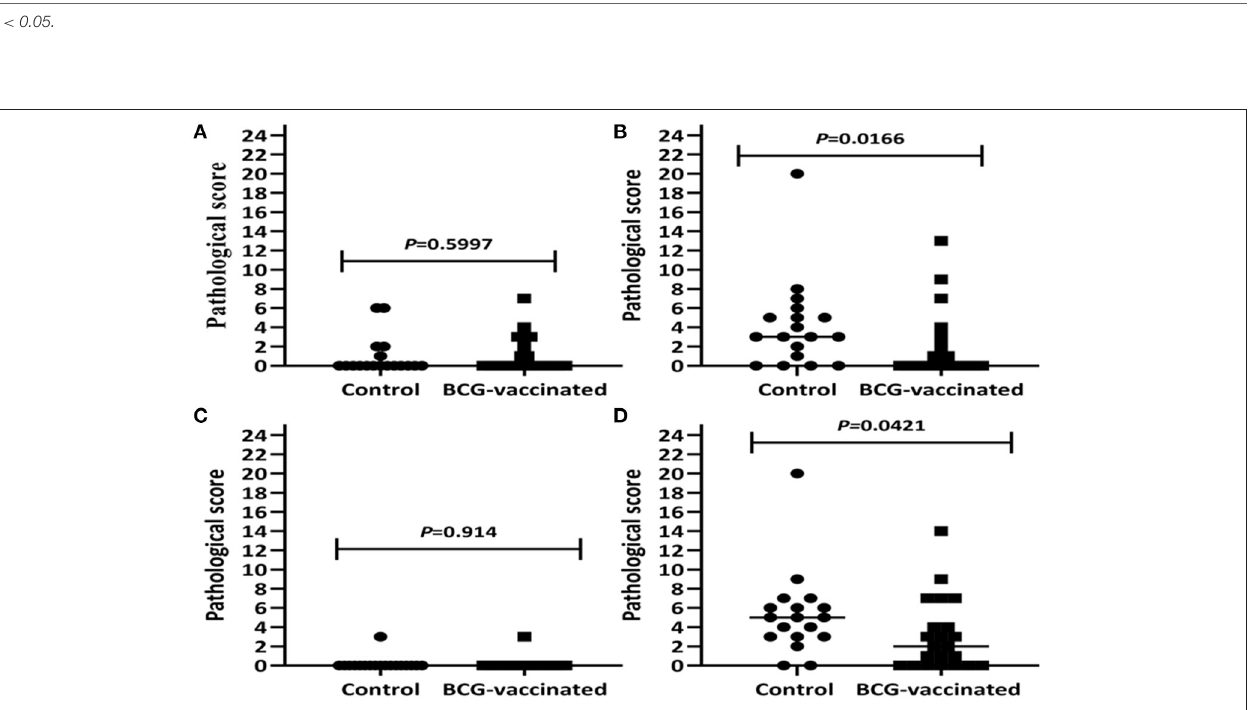
FIGURE 7 | Pathology scores of the experimental calves. Comparison of pathology scores of lymph nodes of the head region (A) , the thoracic lymph nodes and lungs (B) , abdominal lymph nodes (C) , as well as the total pathology score (D) in the vaccinated and control calves are presented by the figure. The individual score is represented by a solid circle for the control group and a solid square for the vaccinated group, and medians are indicated by horizontal line. The total pathology score was significantly ( p < 0.05) lower in the vaccinated calves than in the control calves that was due to the reduction of the pathology score in the tissues of the thoracic